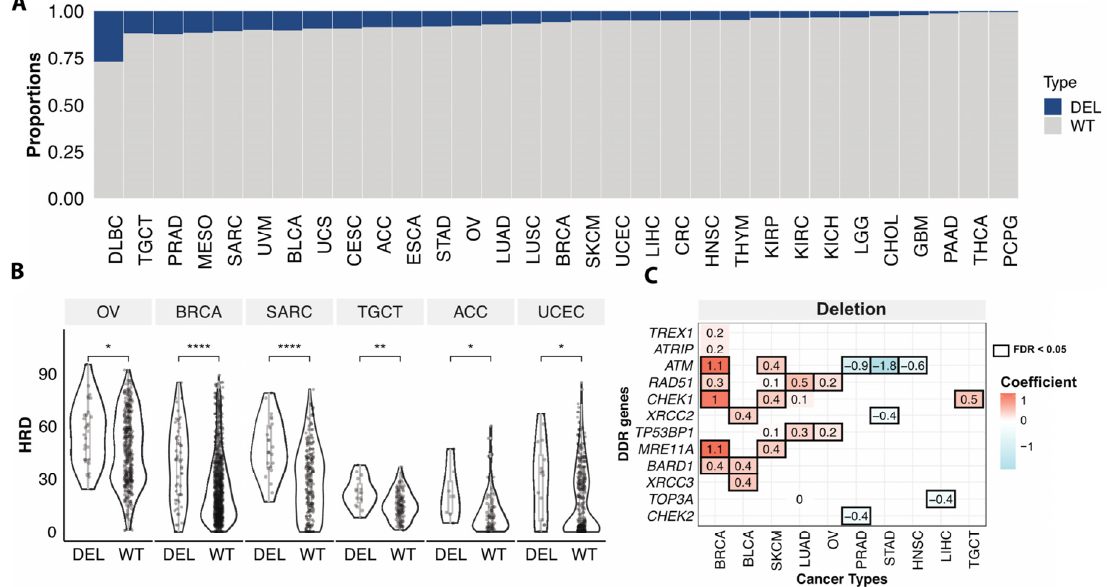
Figure 3. The interaction between germline pathogenic variants and somatic driver mutations. ( A ). Co-occurring germline variants and somatic mutations across all cancers. ( B ). Co-occurring germline variants and somatic mutations within each cancer type. The x -axis shows germline-affected genes, and the y -axis shows somatic-affected genes. Color denotes the Fisher exact test − log10( p value) showing the significance of the germline and somatic interaction. Red and blue indicate co-occurrence and mutual-exclusivity, respectively. ( C ). The distribution of HRD score in only germline (g) BRCA1 ( n = 2), only somatic (s) TP53 ( n = 306), and both carriers ( n = 16). WT indicates samples without either of the mutations ( n = 622).